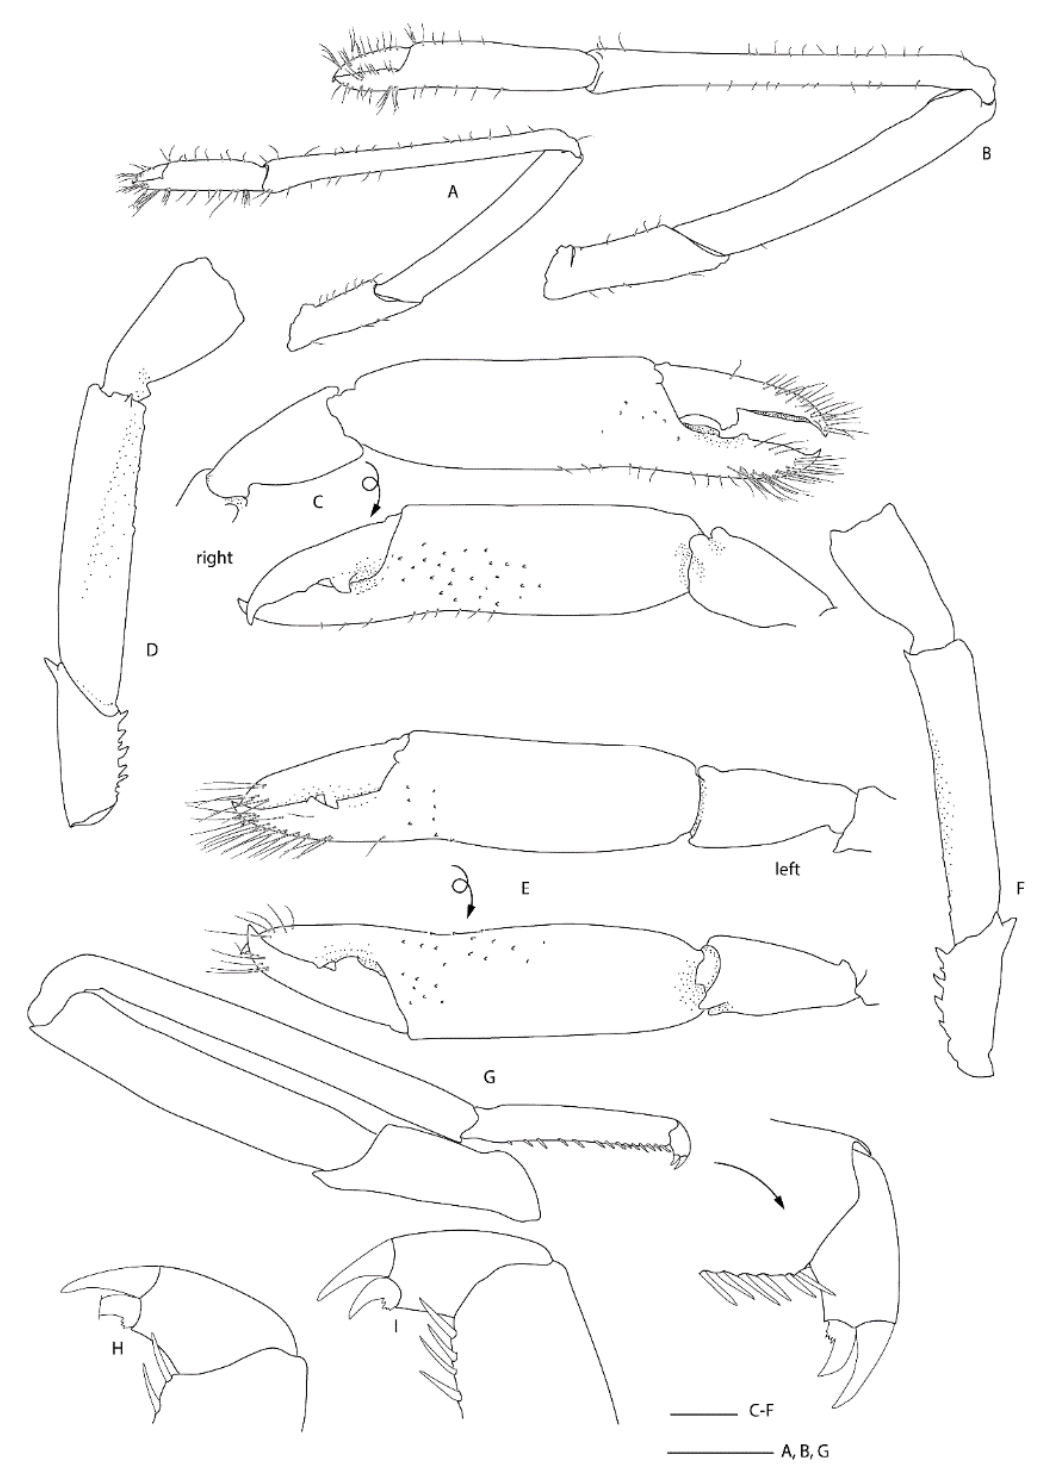
Figure 17. Spongicoloides sonne sp. nov. (NMNZ CR.019650). ( A ) Left P1, lateral. ( B ) Left P2, lateral. C . Right P3, distal portion, lateral (top) and mesial (bottom). ( D ) Right P3, proximal portion, lateral. ( E ) Left P3, distal portion, lateral (top) and mesial (bottom). ( F ) Left P3, proximal portion, lateral. ( G ) Right P4, lateral, inset detail of dactylar spination. ( H , I ) Dactyli and distal propodi of loose left P4 or P5. Scale bars = 2 mm. Material examined. Holotype: F ov. (PCL: 15.0 mm); Southern Kermadec Ridge, 35.380 ◦ S, 178.980 ◦ E, 1184.1 m; 7 February 2017; RV Sonne Stn. SO254/33ROV08,